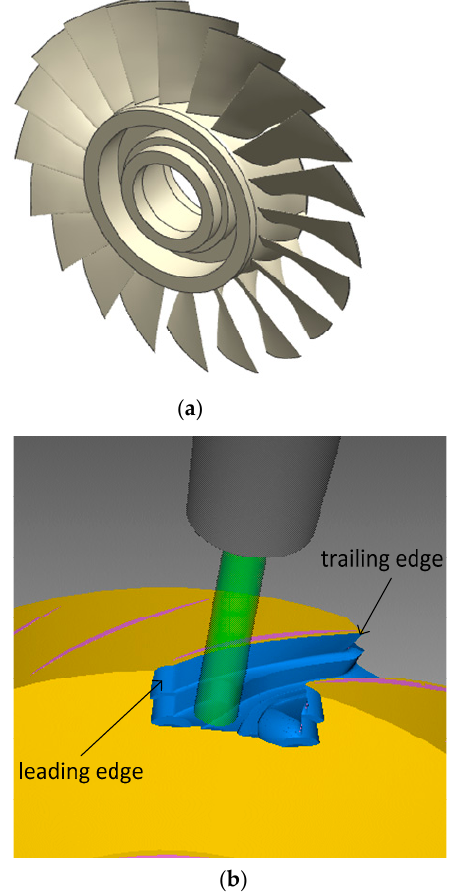
Figure 6. ( a ) A blisk with 20 channels, and ( b ) the cutter cuts the channel from the leading edge to the trailing edge.